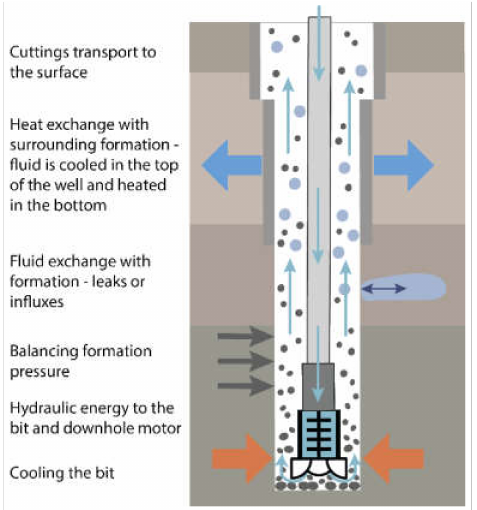
Figure 3. The drilling fluid circulation